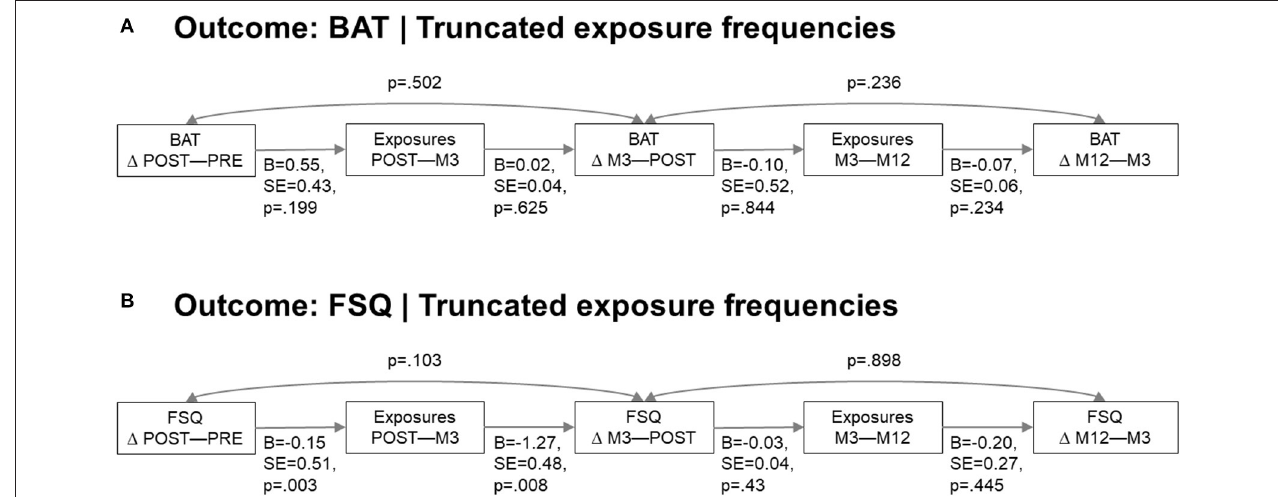
FIGURE 2 | Sequential SEM. (A) Sequential model with BAT outcome. (B) Sequential model with FSQ